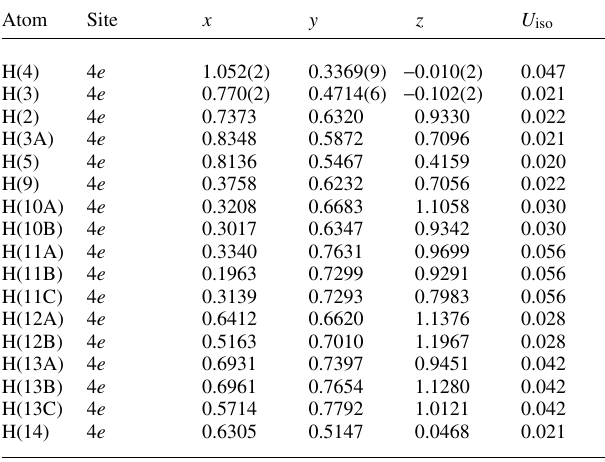
Table 2. Atomic coordinates and displacement parameters (in Å 2 )